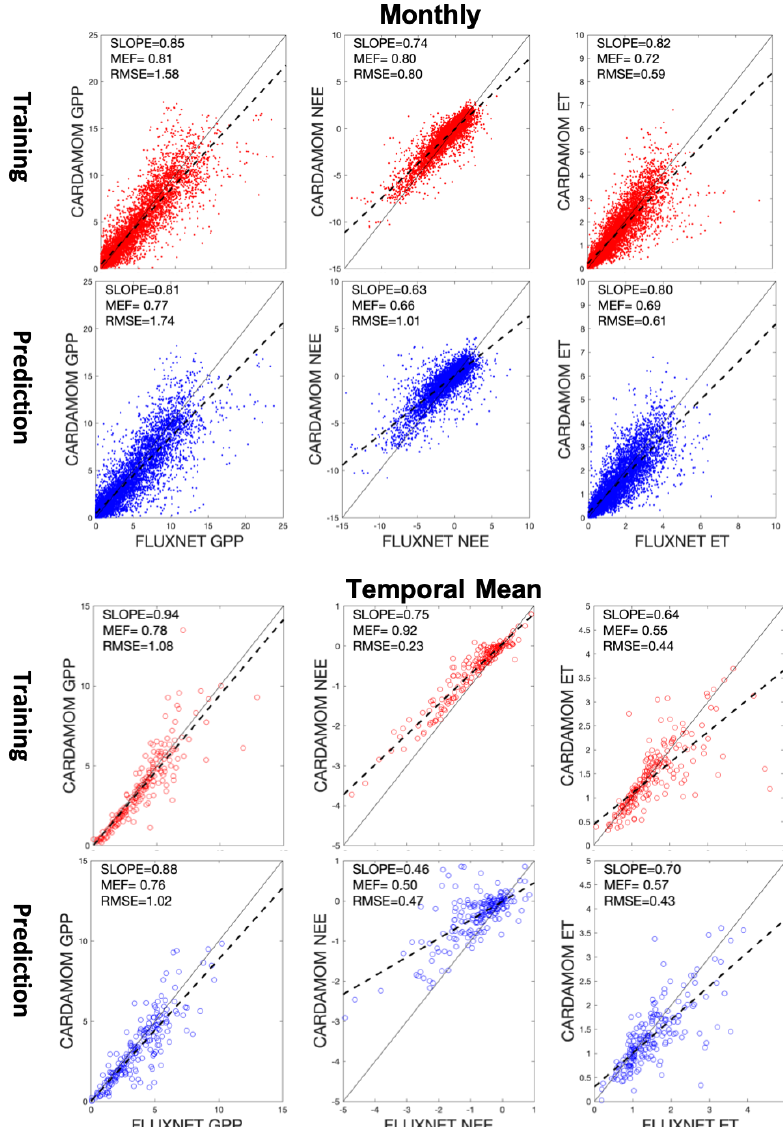
Figure 2. Scatter plots of CARDAMOM outputs (GPP, NEE, and ET) versus observations from FLUXNET data (A1 scenario). Scatter plots in red are results from the assimilation window, and the scatter plots in blue are for the prediction window. We plotted the data both from a monthly basis (top two panels) and at site level using the long-term averages (bottom two panels) for comparison.